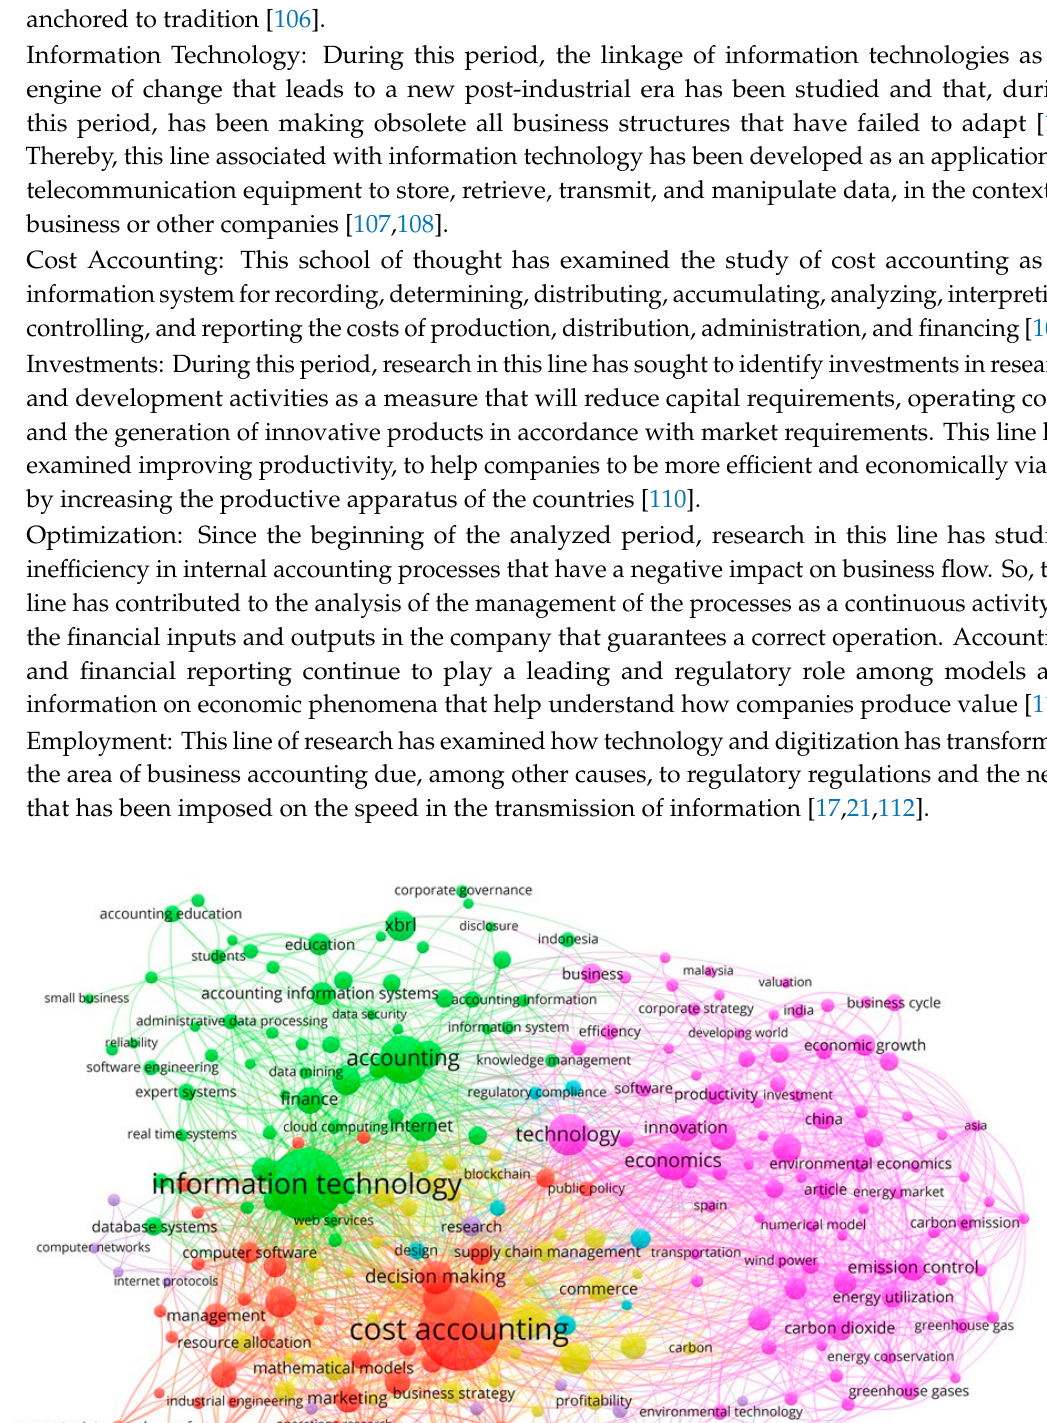
Table 5. Clusters of keywords (1961-2019). Cluster Number Cluster Color (See in Figure 5)